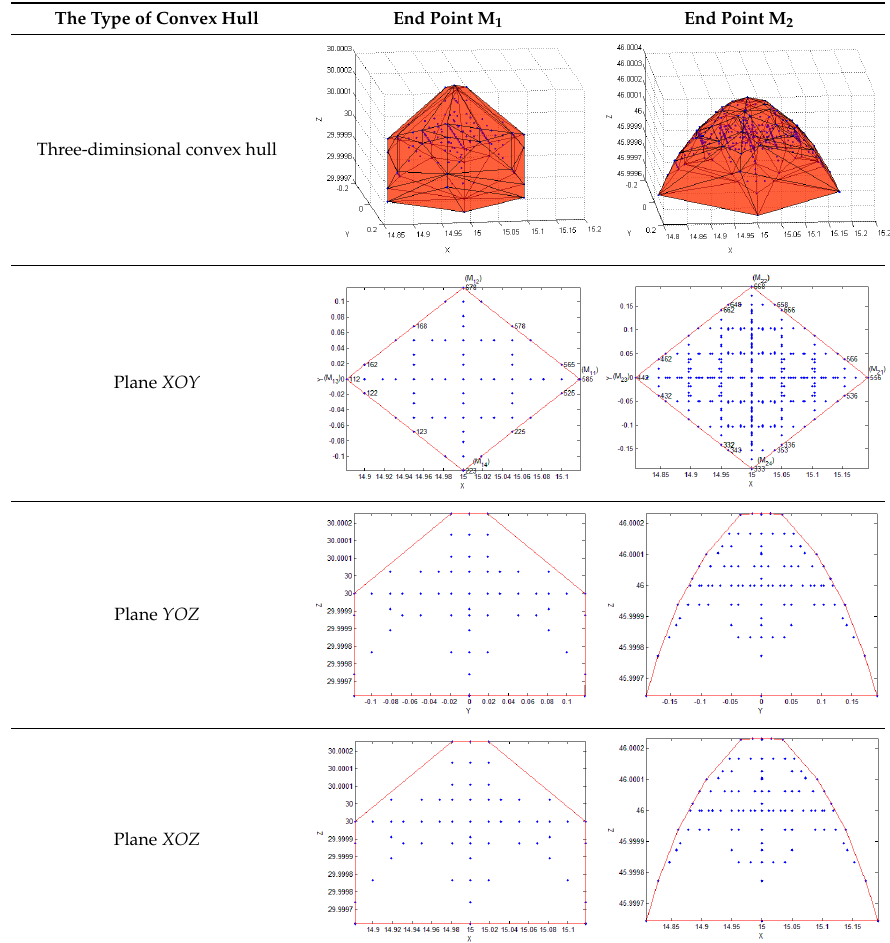
Table 1. Envelope diagram concerning variations of end point M 1 and M 2 of the leading shaft.